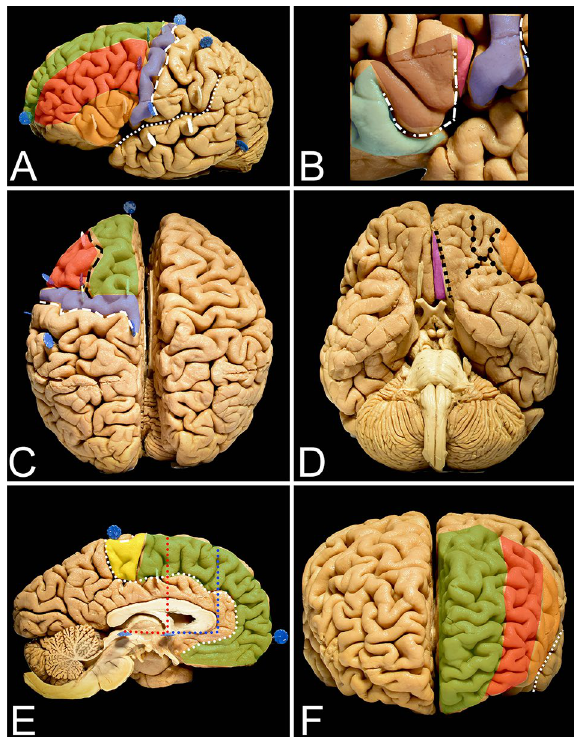
Figure 2. Figure describes. ( A ) The lateral surface is localized anterior to the central sulcus (white dashed line), below the superior margin of the hemisphere and superior to the lateral sulcus (white square-dotted line) and free margin. The vertically oriented precentral gyrus (blue) containing the primary motor cortex is anterior to the central sulcus. The three horizontally oriented gyri of the frontal lobe (superior—green, middle—red and inferior—orange) separated by the superior and inferior sulci are located anterior to the precentral sulcus. ( B ) The inferior frontal gyrus is limited by the lateral sulcus inferiorly and inferior frontal sulcus superiorly and is divided into the pars orbitalis (light blue), pars triangularis (burgundy) and pars opercularis (pink) by the horizontal (white two-dash line) and ascending rami (white dot-dash line) of the lateral sulcus. ( C ) From the superior perspective, mainly the superior and middle gyri, which are separated by the superior frontal sulcus (black dashed line). ( D ) The basal surface of the frontal lobe is formed by a thin medially located gyrus rectus (purple), and a larger lateral part is formed by the four orbital gyri which are separated by the H-shaped orbital sulcus (black dotted line). The border between the lateral and medial parts is marked by the olfactory sulcus with the olfactory tract (black square dot line). ( E ) The mesial surface of the frontal lobe is formed by the paracentral lobule (yellow), superior frontal gyrus and cingulate gyrus, which are separated by the cingulate sulcus (white dotted line). The SMA proper is defined as the region anterior to the motor cortex. The anterior border is set by an imaginary line (red dotted line) perpendicular to the line connecting the anterior and posterior commissure, at the level of the anterior commissure. The anterior border of the pre-SMA is less defined, and it is marked by a line (blue dotted line) parallel to the previous and tangential to the most rostral part of the corpus callosum. f. The anterior surface of the lateral portion of the hemisphere is formed by the superior, middle and inferior frontal gyri, and the lateral sulcus is located